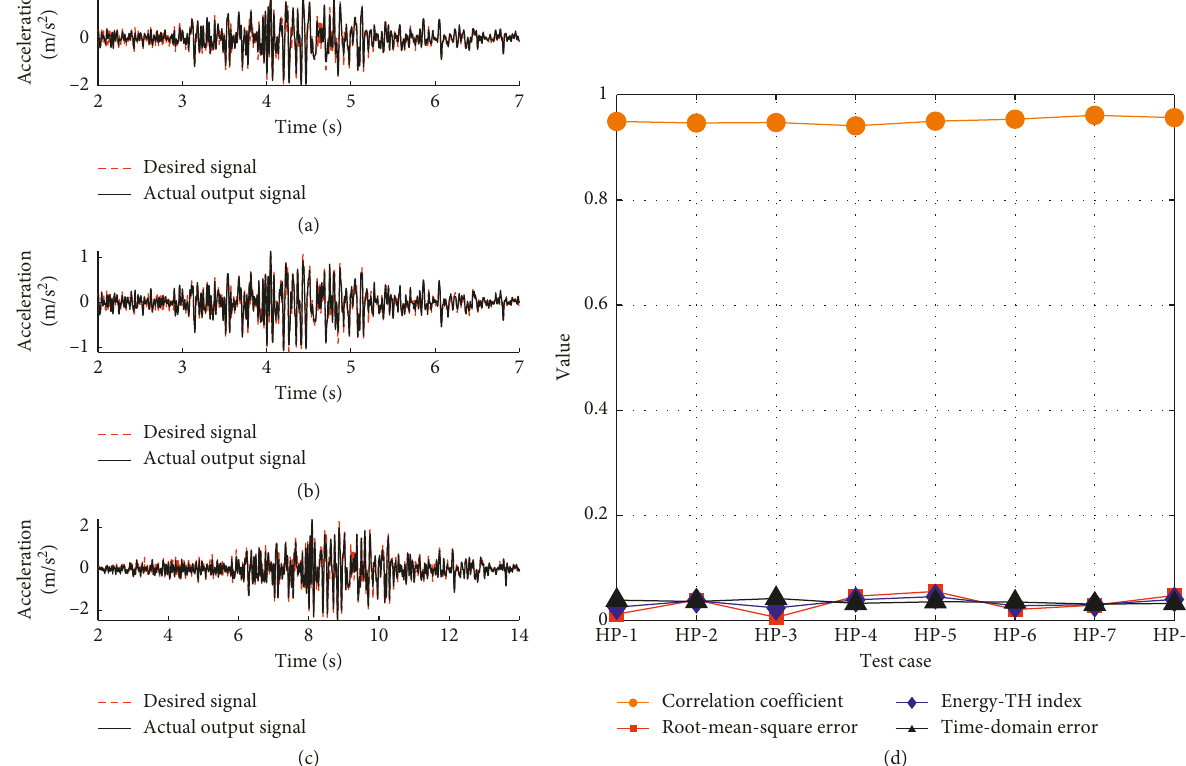
Figure 19: Shake table’s output and corresponding error of different test cases with high-speed railway bridge piers. (a) Case HP-1; (b) case HP-3; (c) case HP-5; (d) output error of test